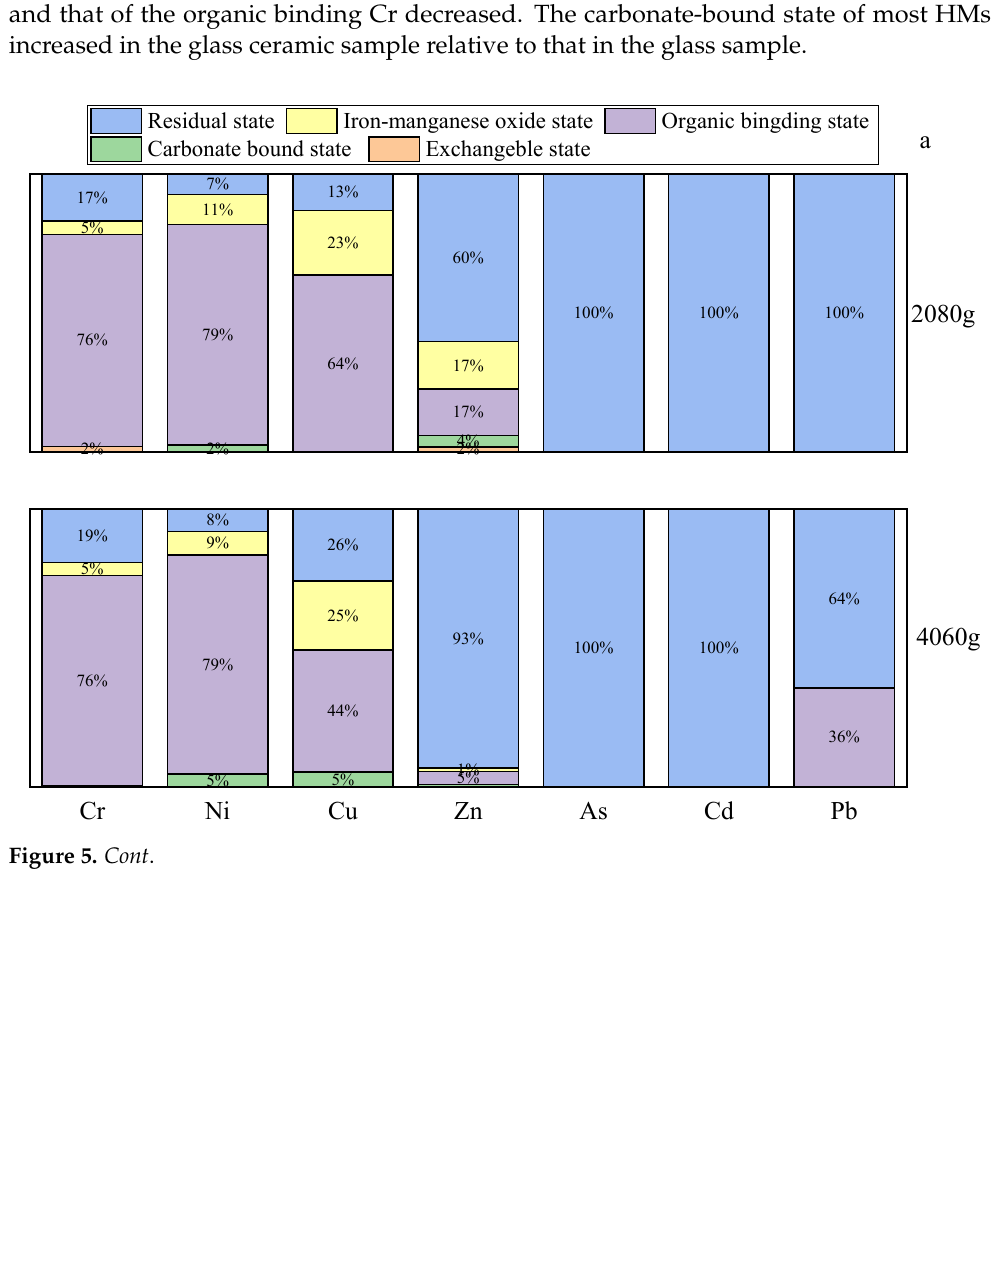
5050c Figure 5. HM distribution patterns in ( a ) glass and ( b ) glass ceramic samples.